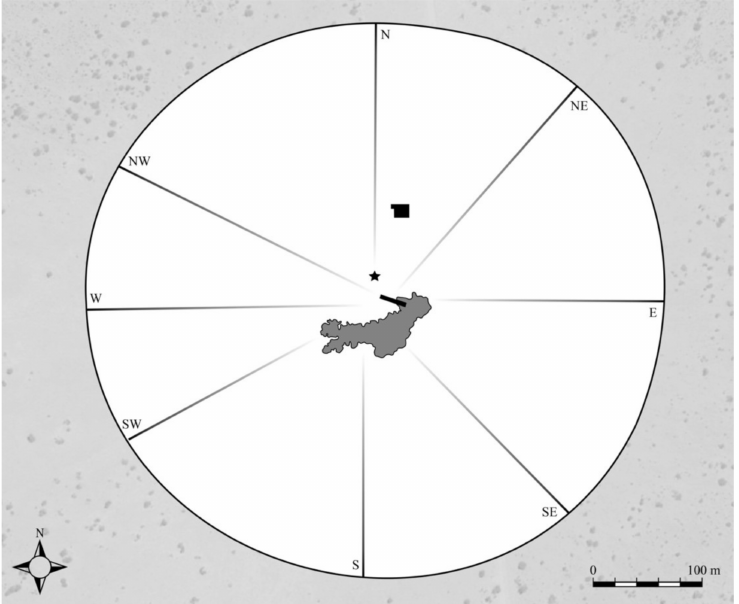
Figure 1. Map of the Mushara waterhole and surrounding 0.22 km 2 clearing, located in the northeast- ern corner of Etosha National Park, Namibia. The center of the map is marked by a water trough (rectangle shape), which is filled by an artesian well that is controlled by a ball valve. The water spills out from the east end of the trough, creating a small pan (in gray). Approximately 80 m north of the trough is the 8 m observation tower where researchers were positioned during playback experiments. The star on the map marks the location of the hidden speaker used to broadcast the estrous vocalization remotely from the tower. The vocalizations are presented to male elephants as they reach the edge of the clearing (perimeter circle). Major elephant pathways to and from the waterhole are depicted and directions